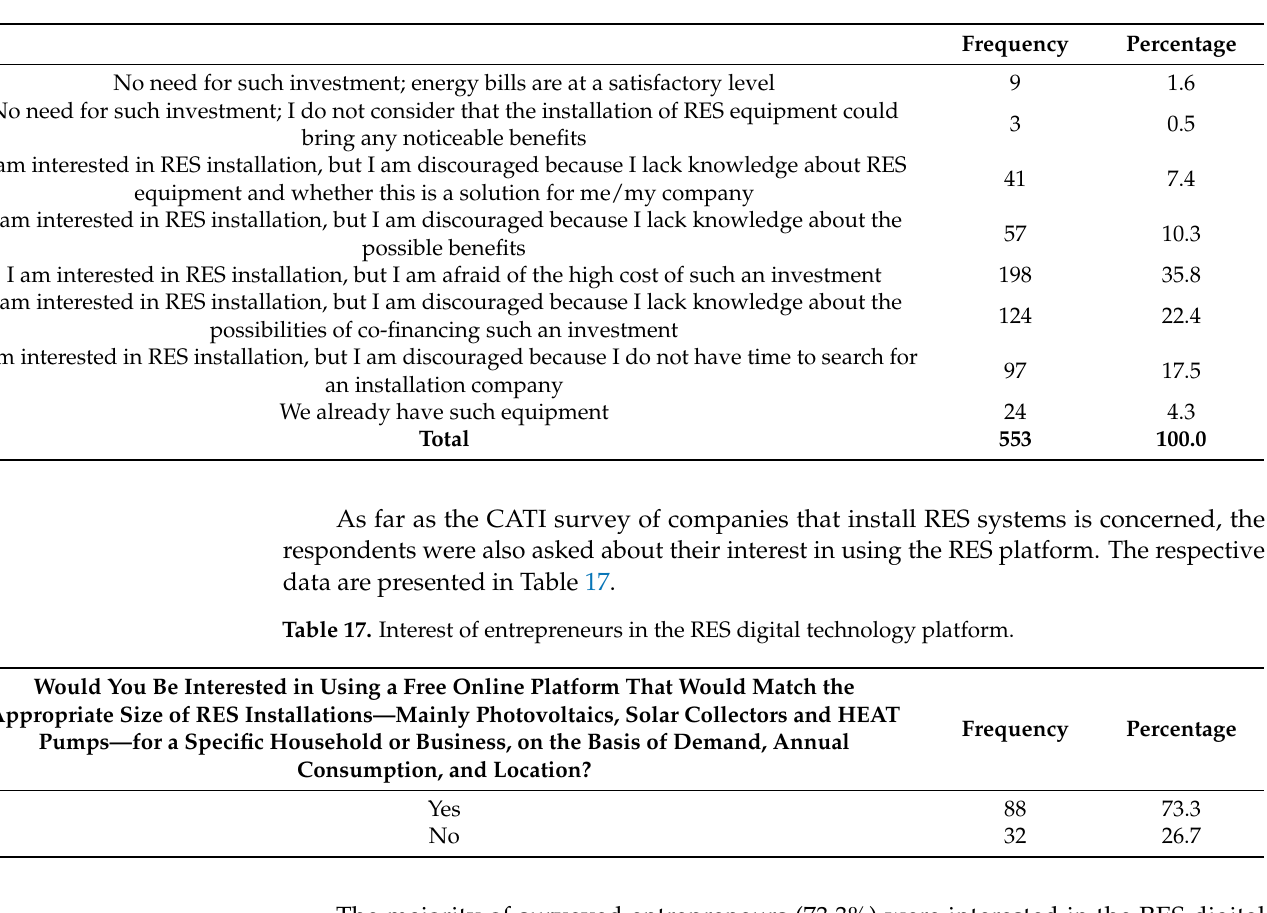
Table 16. Factors discouraging respondents from the installation of RES systems.